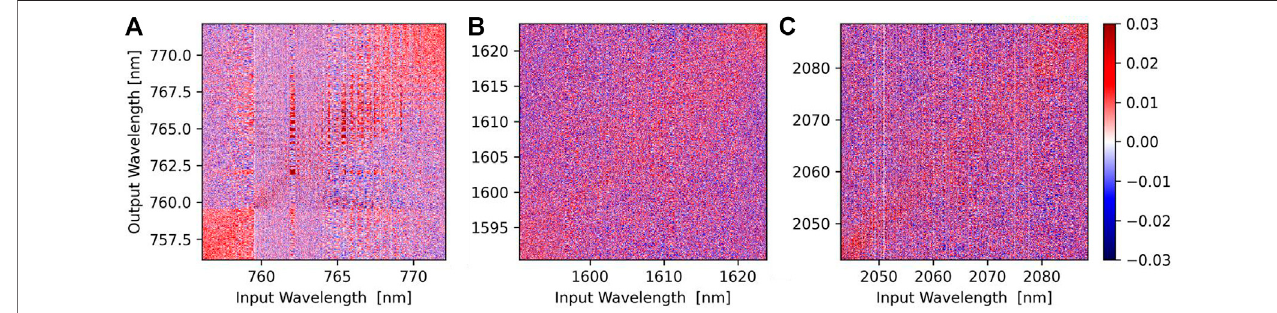
FIGURE4| Correlationmatrix, A ,fortheO2A-band (A) ,WCO2-band (B) ,andSCO2-band (C) .Inputwavelengthsareshownonthe x -axisandoutputwavelengths on the y -axis. Positive entries are shown in red, negative entries in blue.